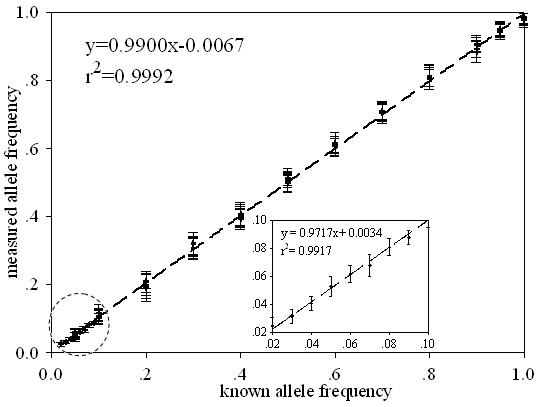
Scatter plot demonstrating the accuracy of allele frequency estimation using pooled DNA samples. The chart is drawn based on the results for allele frequency listed in Table 2 and Table 3 versus the known frequencies prior to PCR amplification for the six SNPs. Short horizontal bars are error bars. The diagonal line shows complete concordance between known and observed allelic fractions.